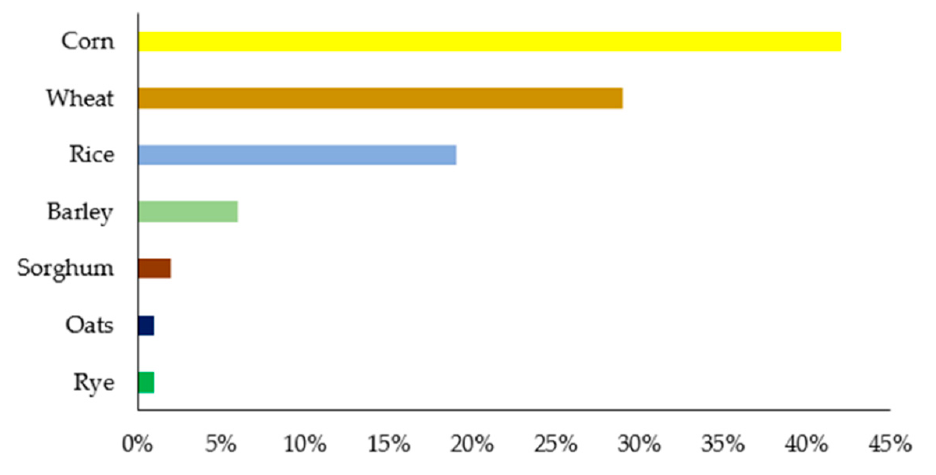
Figure 4. Global cereal production 2020–2021 [4]. Table 4. Functional beverages with cereal waste as an